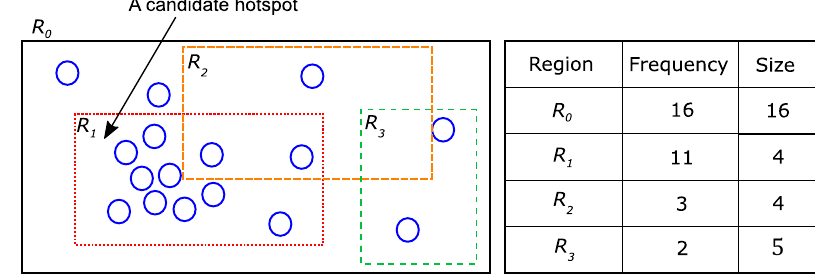
Figure 5. An example of the